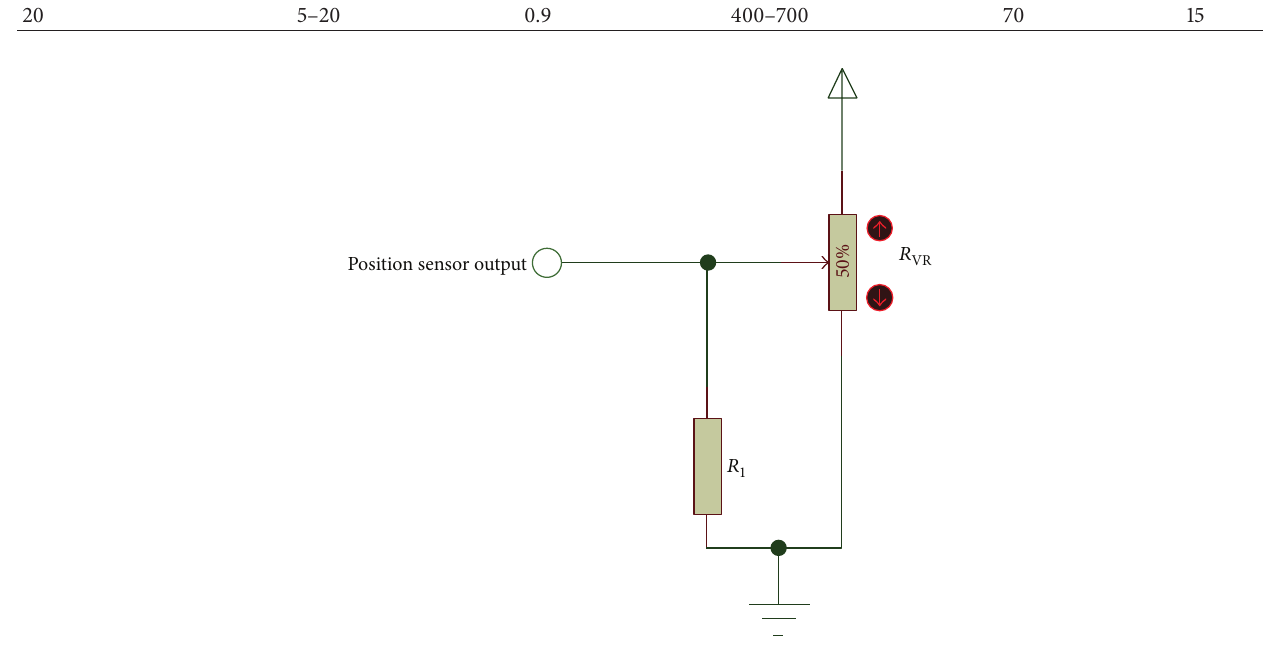
Figure 9: Position sensor